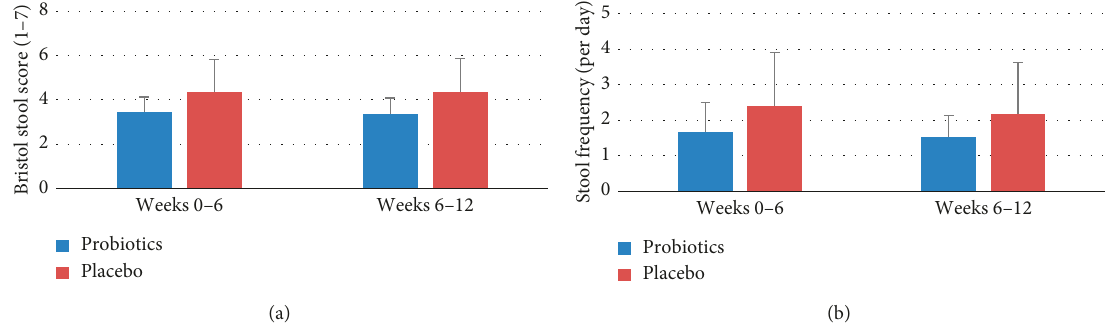
Figure 7: Average stool type according to the 7-points Bristol stool scale (a) and number of stools per day (b) in patients using probiotics ( n 13) or placebo ( n (cid:31) (cid:31)